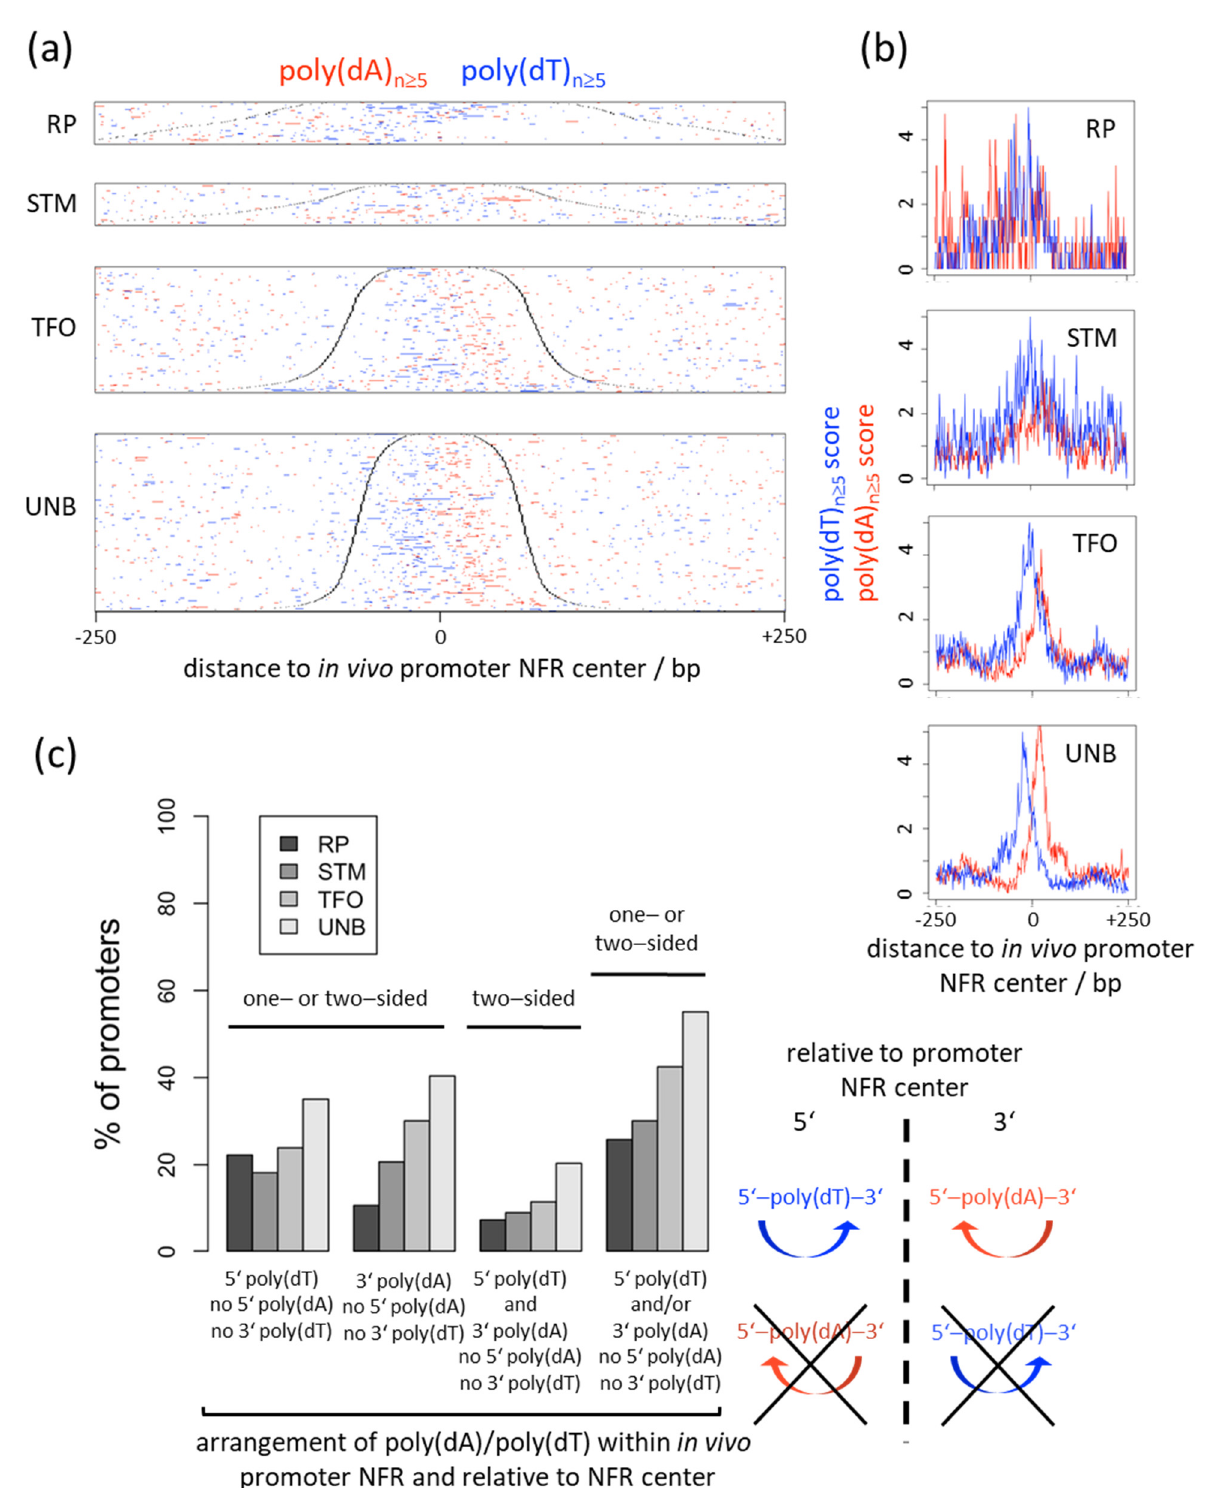
Figure 5. S. cerevisiae promoters evolved a strand-biased distribution of poly(dA) vs. poly(dT) tracts relative to their NFR centers that conforms with an active and directional RSC-mediated nucleosome depletion mechanism. ( a ) Heatmap as in Figure 1, leftmost panel, but aligned at NFR centers [16] and sorted from top to bottom by increasing NFR length. Black dots mark the downstream and upstream border of the − 1 and +1 nucleosome, respectively. ( b ) Composite plots as in Figure 2, leftmost panel, but aligned at NFR centers. ( c ) Left: the percentage of promoters in the indicated gene groups that have at least one poly(dA) or poly(dT) tract of length ≥ 5 bp in their NFR and conform with the one- or two-sided arrangement